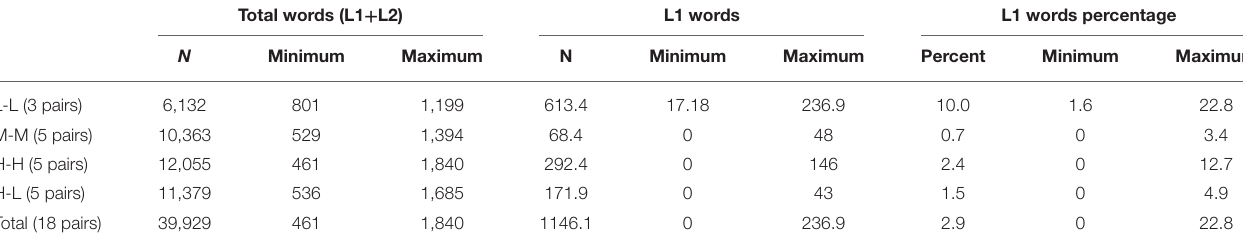
TABLE 4 | The number of total words and percentage of L1 words per proficiency pairing.